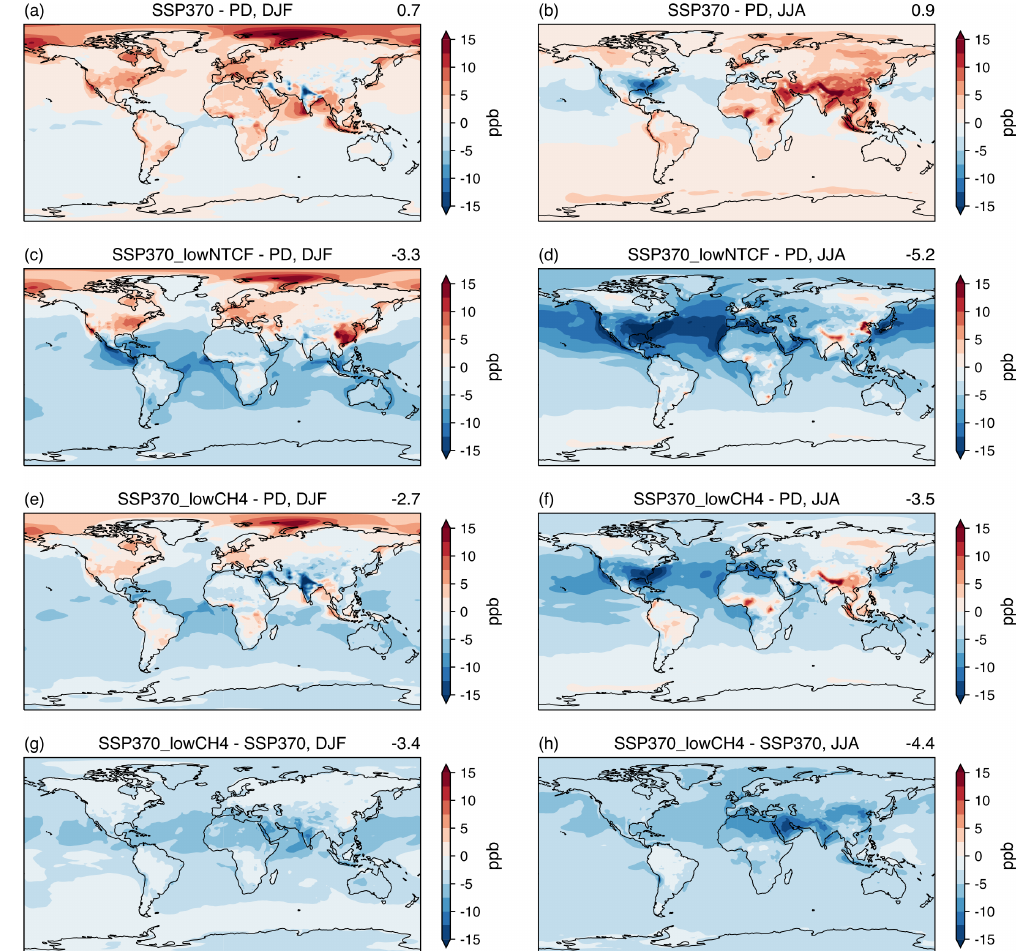
Figure 4. Differences in seasonal mean surface O 3 mixing ratios between the present day (PD; 2004–2014) and the future SSP3-7.0 (a, b) , SSP3-7.0-lowNTCF (c, d) , and SSP3-7.0-lowCH4 (e, f) (2045–2055) in winter (DJF) and summer (JJA). Differences between SSP3-7.0 and SSP3-7.0-lowCH4 are shown (g, f) to isolate the impacts of reduced CH 4 mixing ratios. Absolute global mean O 3 changes (ppb) are shown at the top right of each